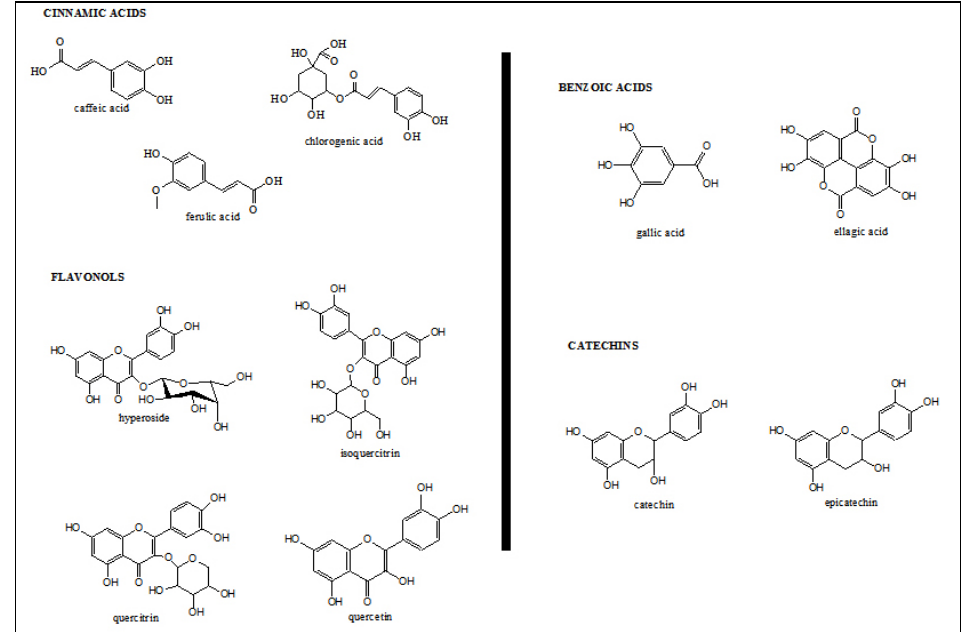
Fig. 1: Chemical structures of the detected polyphenolic compounds.